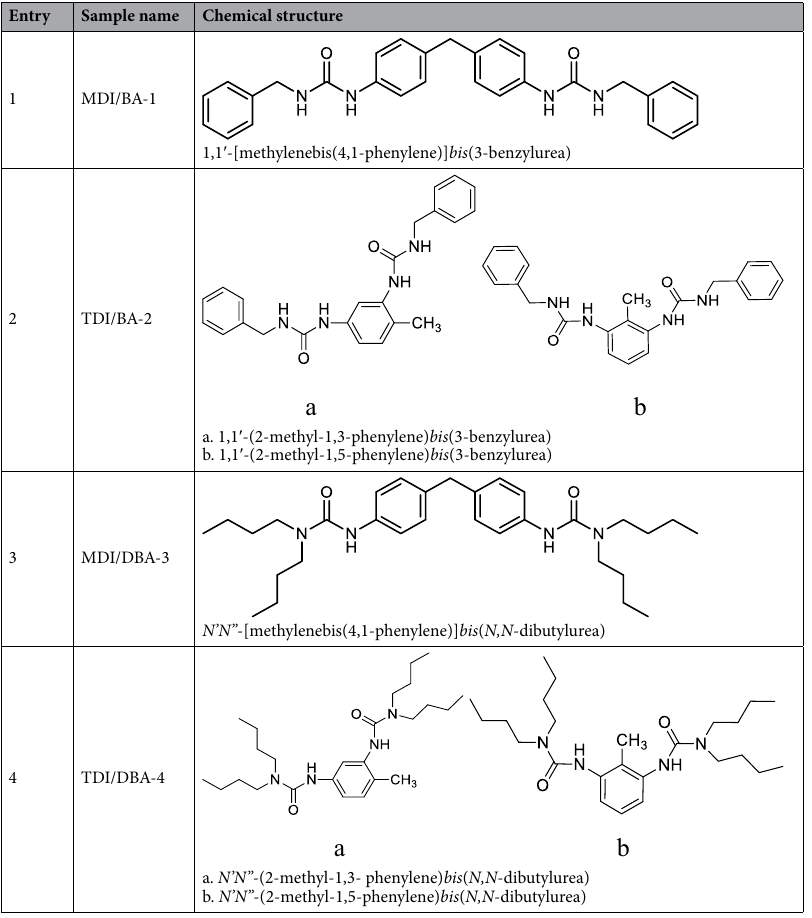
Table 2. DIs derivatization product obtained with benzylamine and